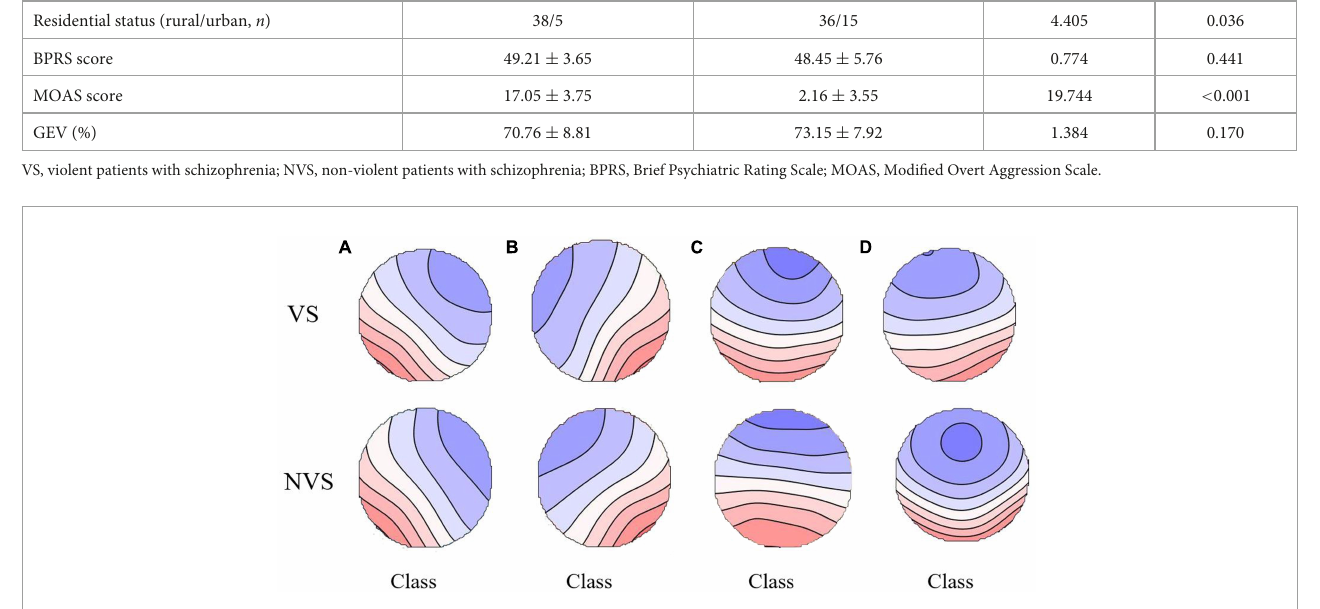
to B” ( P < 0.001), and “B to C” ( P < 0.001), as compared